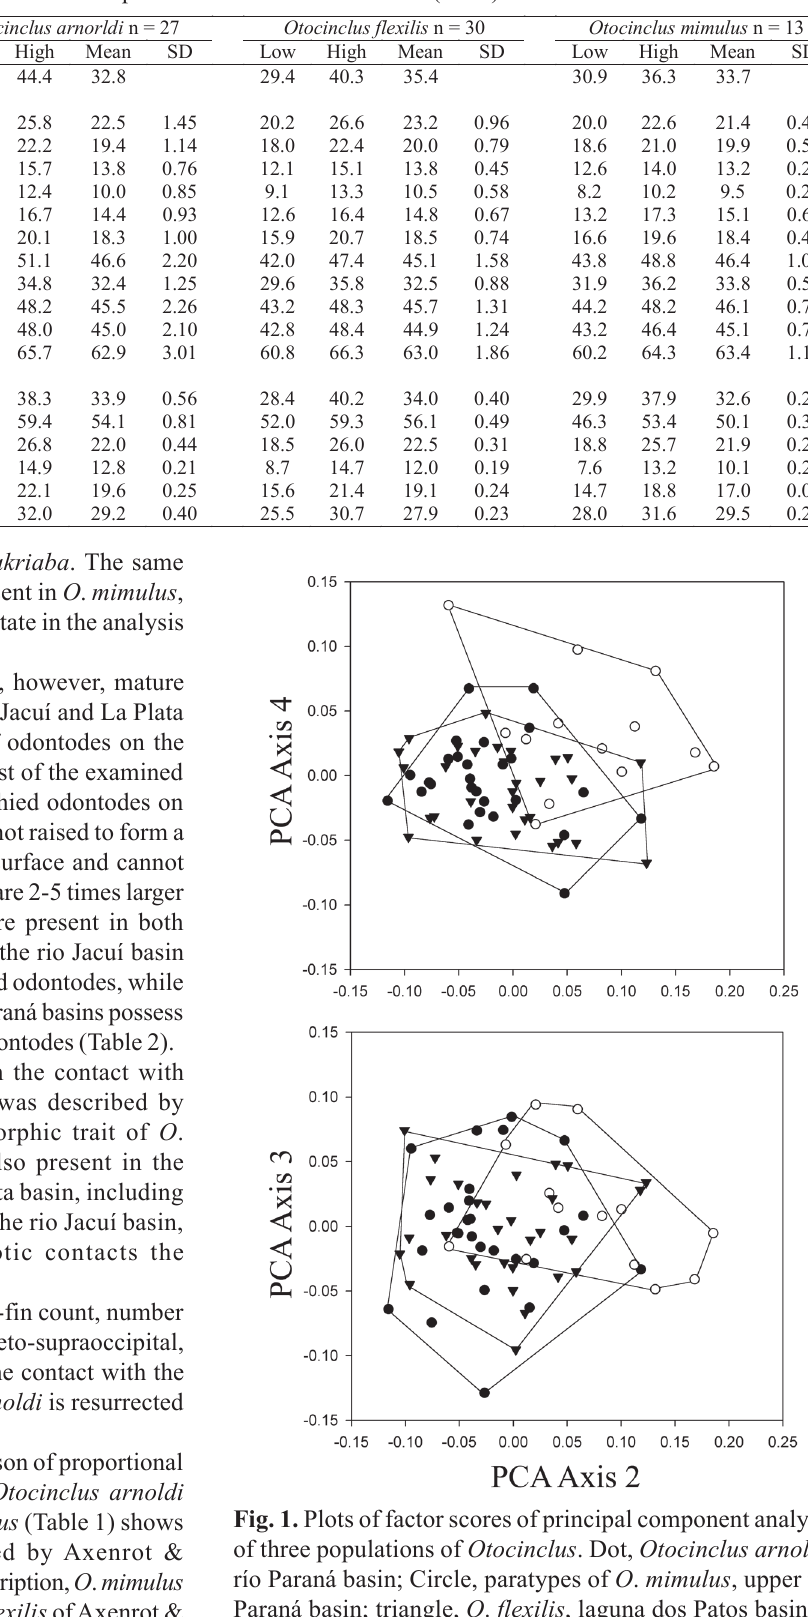
Table 1. Descriptive morphometrics of Otocinclus species. Values are given as percents of standard length or of head length. SD = standard deviation. Numbers in brackets correspond to landmarks of Schaefer (1997).